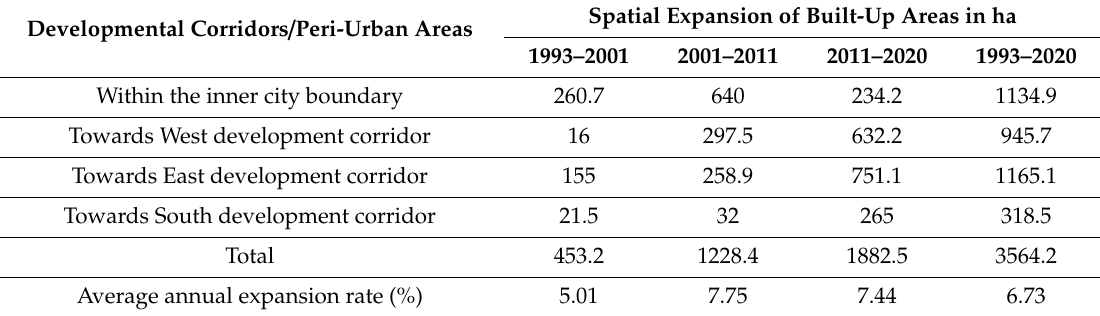
Table 3. The spatial expansion of built-ups towards each developmental corridor / peri-urban